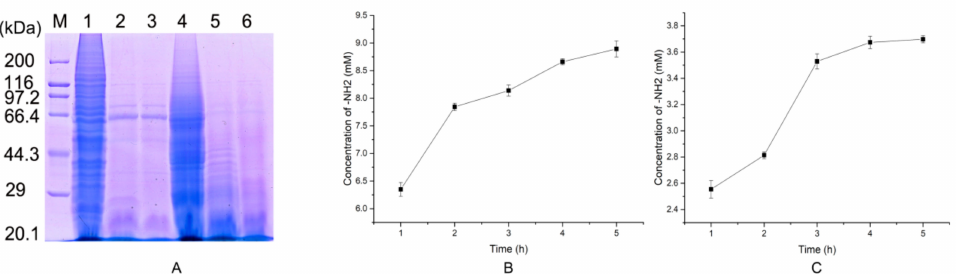
Figure 6. Hydrolysis of native collagen hydrolytic peptides. ( A ). The hydrolysis results after 20 min were analyzed by SDS-PAGE; line marked 1—20 µ L of porcine skin collagen (0.3 mg / mL) with 1 µ L of EH2; line marked 2—20 µ L of porcine skin collagen (0.3 mg / mL) with 1 µ L of EH2 for 10 min at 50 ◦ C; line marked 3—20 µ L of porcine skin collagen (0.3 mg / mL) with 1 µ L of EH2 for 20 min at 50 ◦ C; line marked 4—20 µ L of salmon skin collagen (0.4 mg / mL) with 1 µ L of EH2; line marked 5—20 µ L of salmon skin collagen (0.4 mg / mL) with 1 µ L of EH2 for 10 min at 50 ◦ C; line marked 6—20 µ L of salmon skin collagen (0.4 mg / mL) with 1 µ L of EH2 for 20 min at 50 ◦ C. ( B ). Hydrolysis degree of salmon skin collagen and ( C ) porcine skin collagen treated for 1, 2, 3, 4, and 5 h. Values are expressed as the mean ± SD ( n =